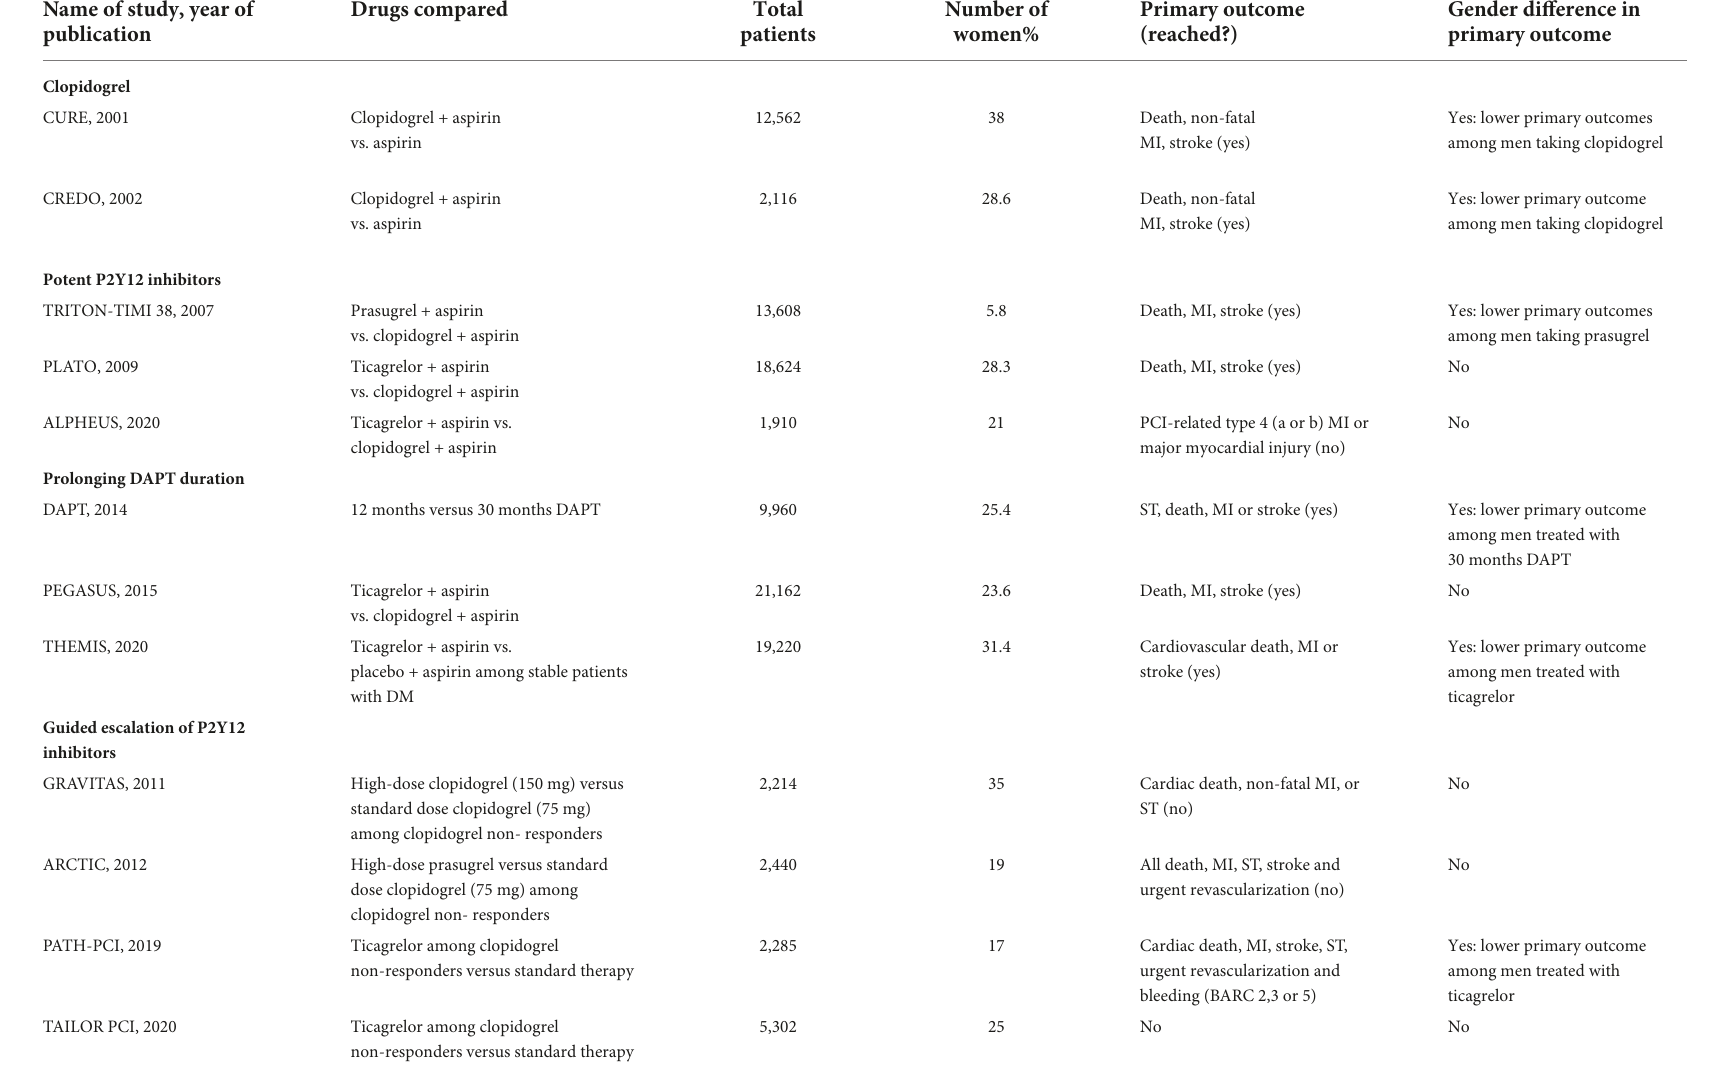
TABLE 1 List of major randomized controlled trials evaluating antiplatelet strategies focused on reducing ischemic events with sub-group analysis by